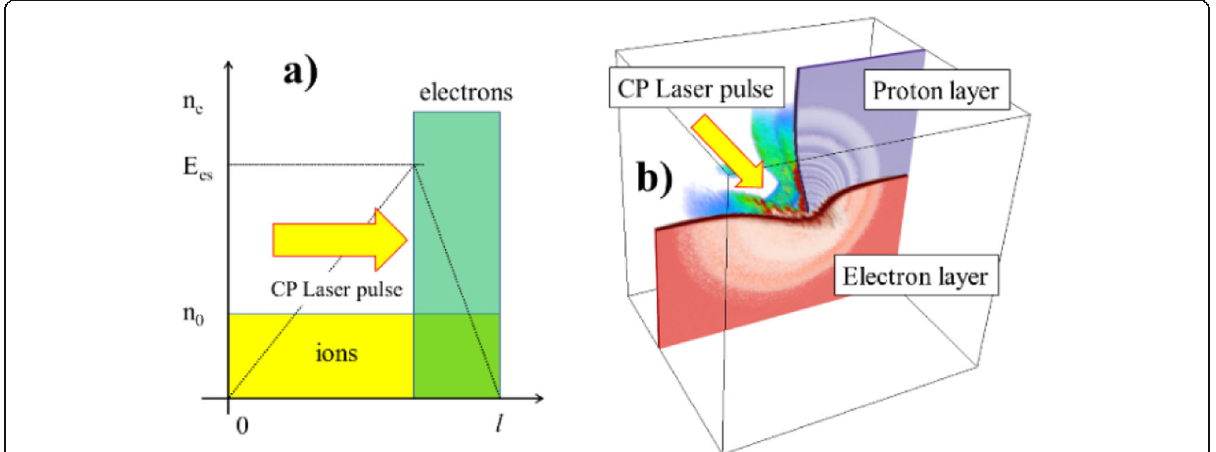
Fig. 18 a Schematic illustration of the radiation pressure acceleration mechanism. A circularly polarized laser pulse pushes electrons in a plasma with thickness l and initial density n 0 as a whole, compressing them to a thin layer with density n e , and then the electrostatic field between electrons and ions pulls the remaining ions. b Density distributions of electrons and protons from a three-dimensional particle-in-cell simulation for the radiation pressure acceleration